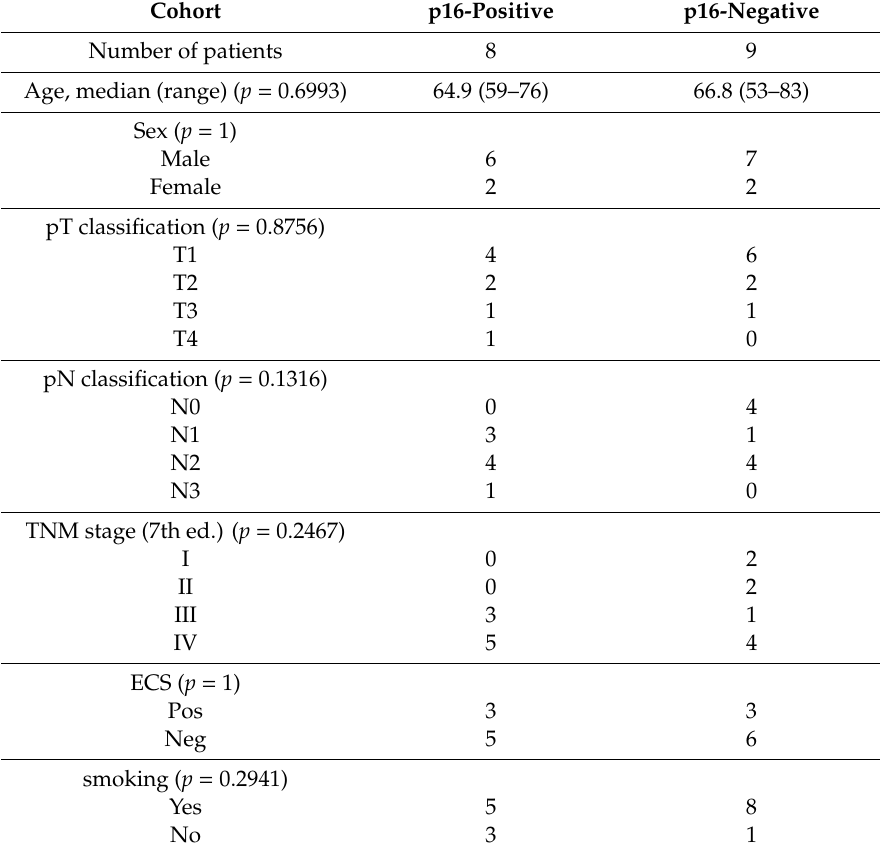
Table 1. Clinicopathological characteristics of OPSCC used in this study. Statistical analyses were performed using a two-sided Mann–Whitney test (age) or Fisher’s exact test (all others) (R,